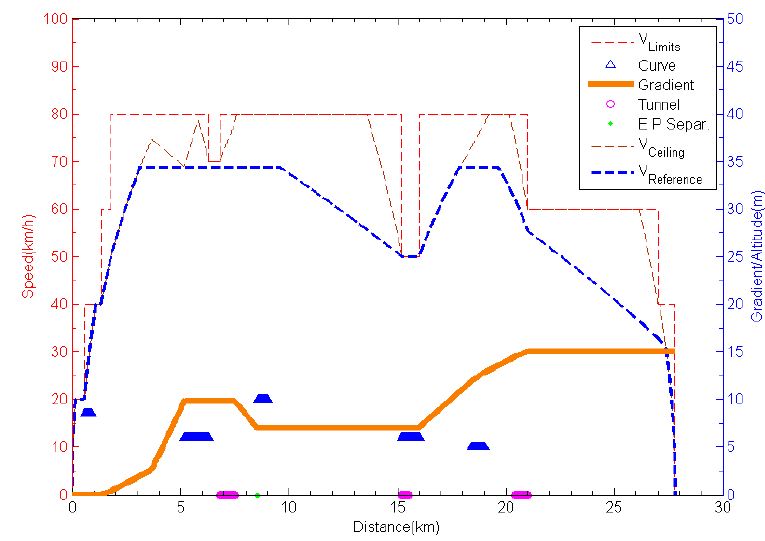
Figure 12. Speed reference profile diagram of a test line.